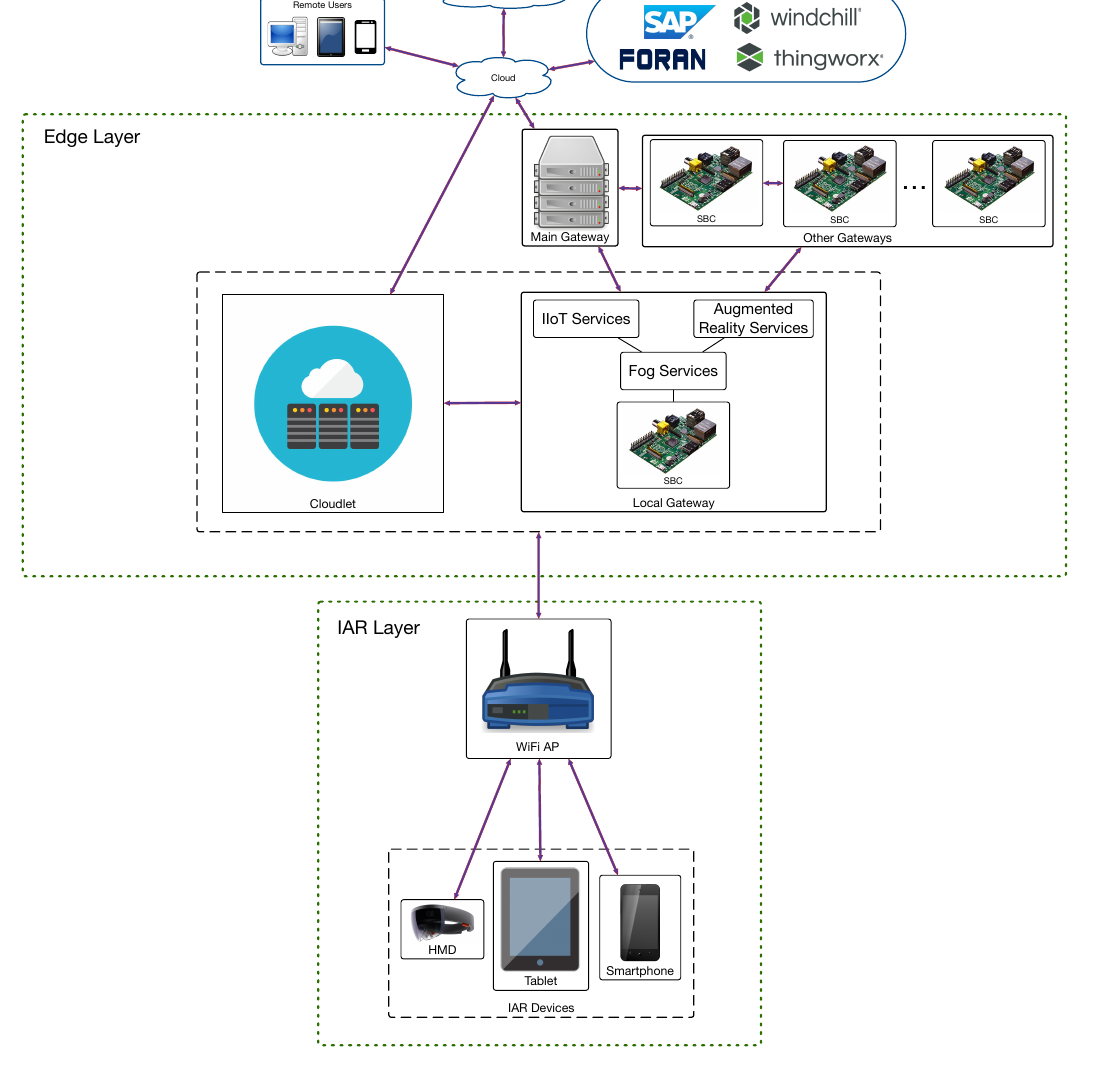
Figure 1. Proposed IAR communications